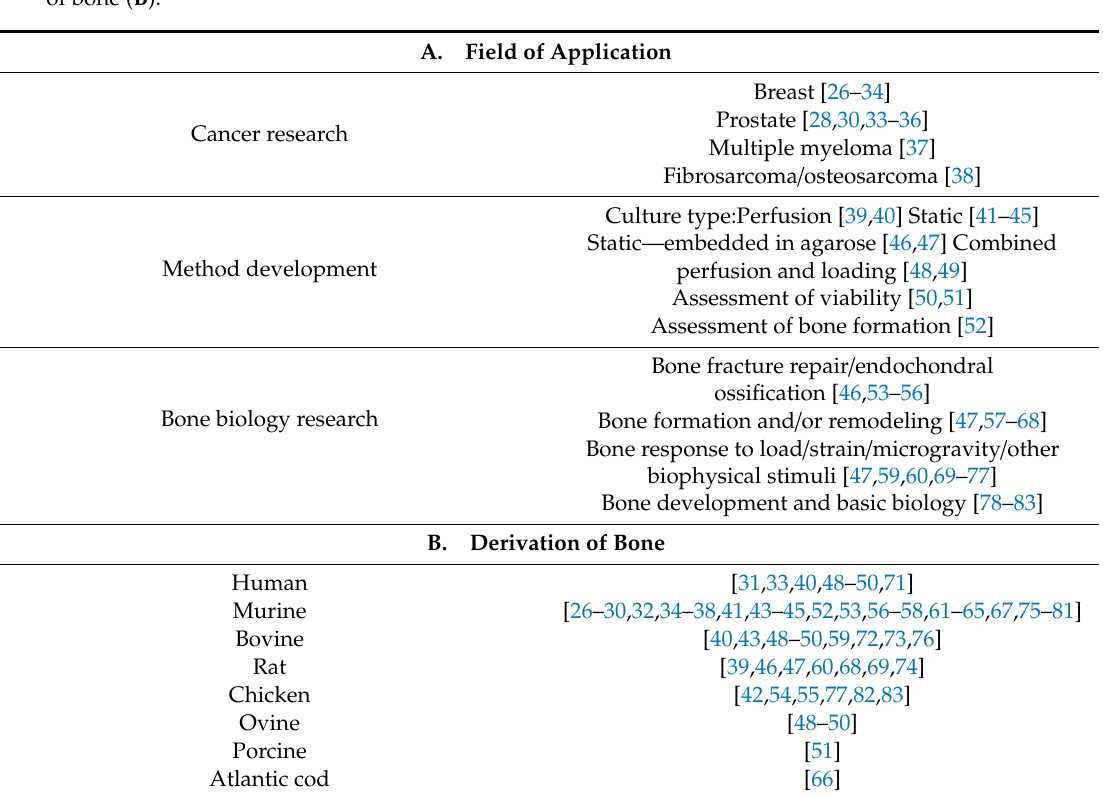
Table 2. Summary of literature on bone tissue cultures, divided by field of application ( A ) or by origin of bone ( B